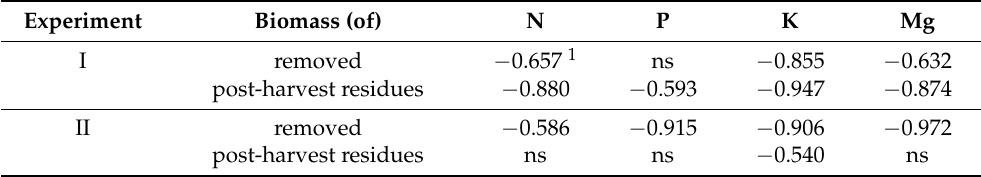
Table 5. Correlation between soil nutrient content and crop biomass removed (harvested) and the biomass of post-harvest